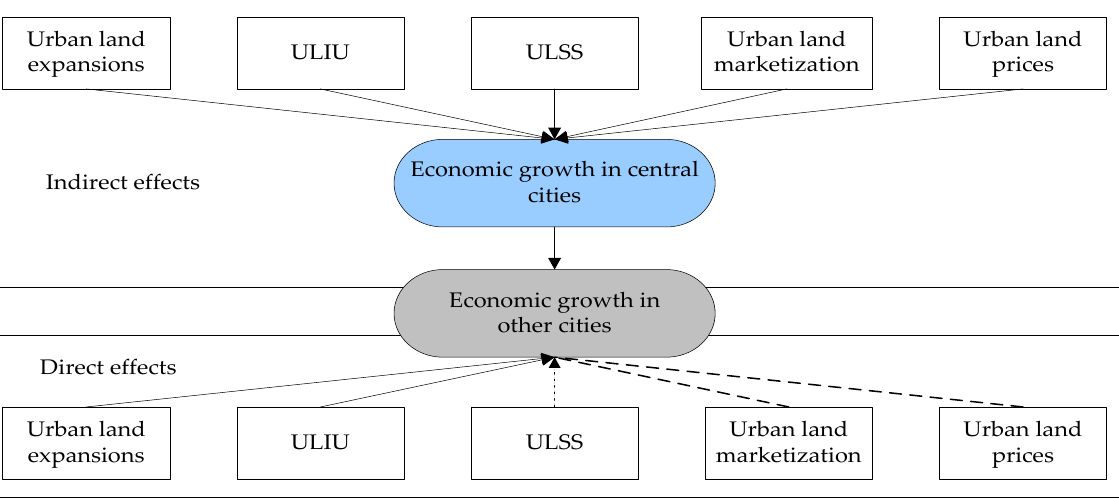
Figure 3. The impacts of ULUT on ESSCC in urban agglomerations.